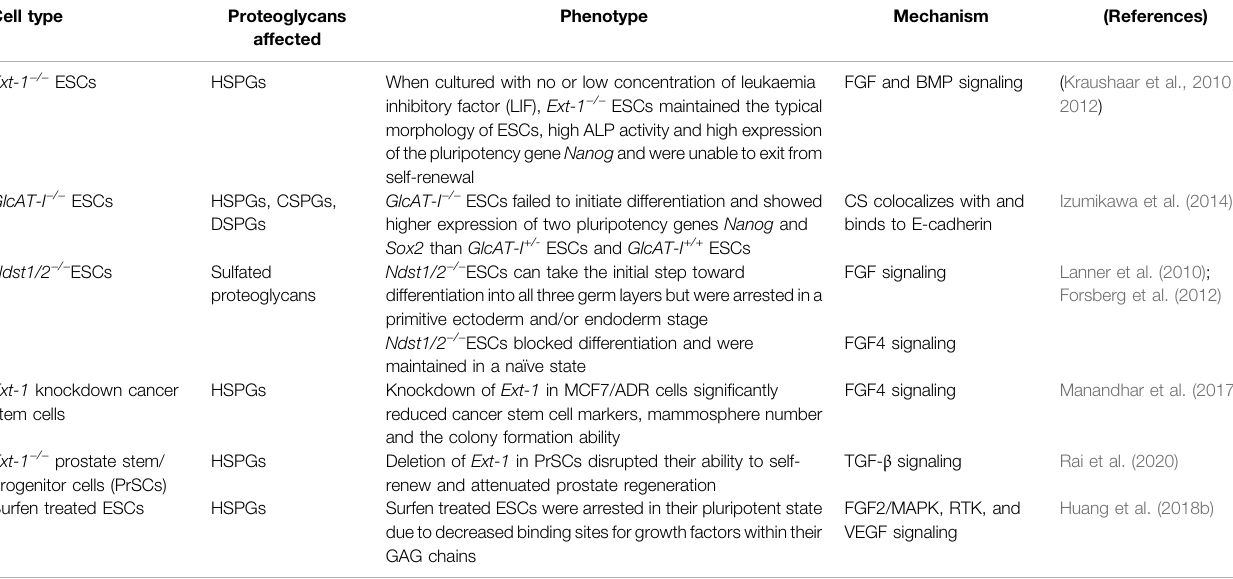
TABLE 1 | Phenotypes of proteoglycan-de fi cient stem